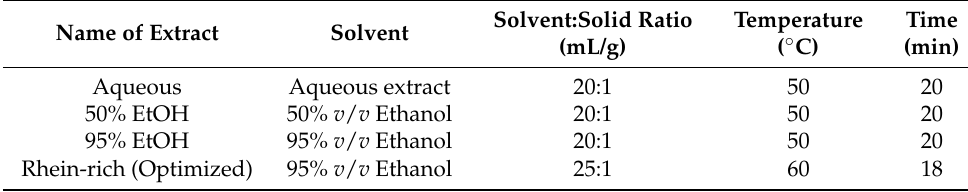
Table 1. Names of extract samples indicating conditions of extraction.